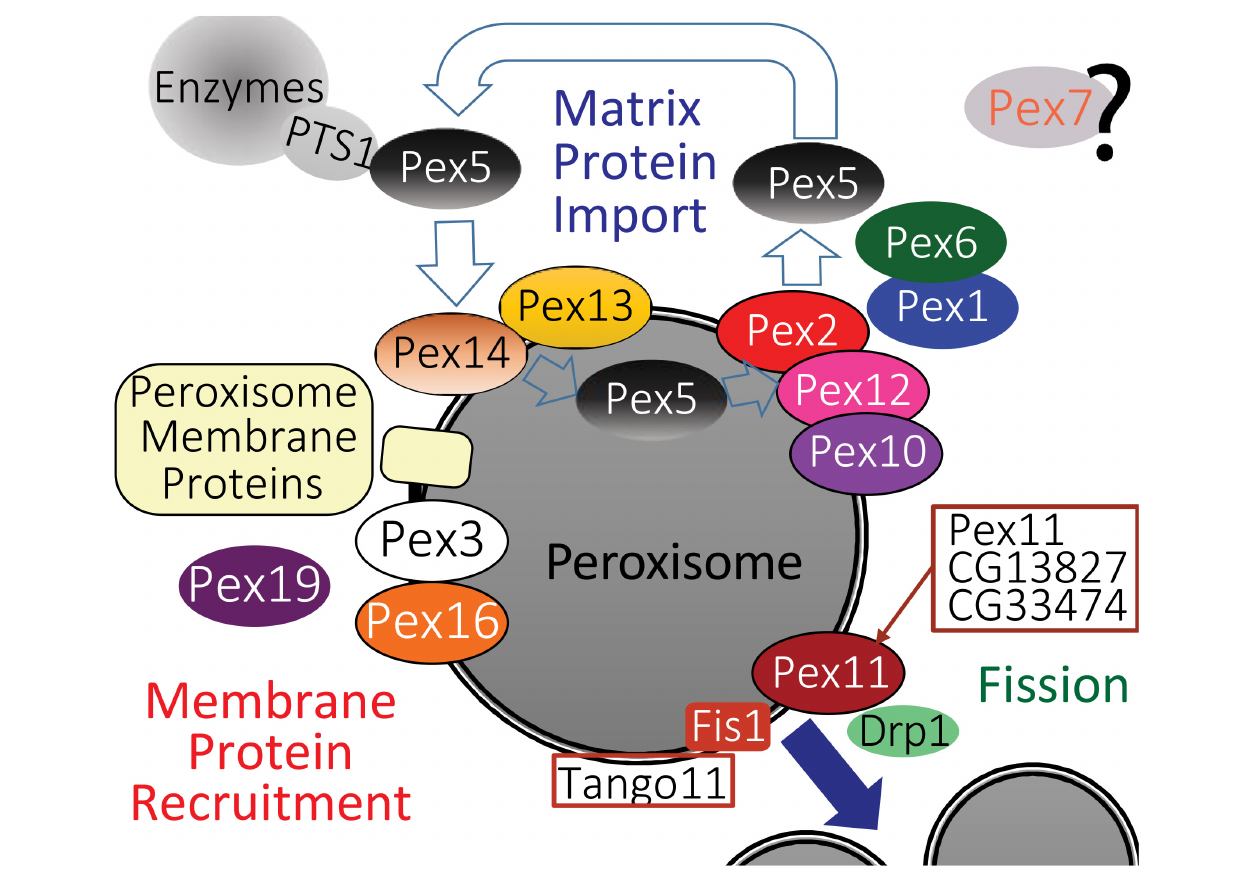
FIGURE 2 | A model for the likely role of the Drosophila homologs of peroxisome biogenesis factors, based on a recent one for mammalian peroxisome proteins by Fujiki et al. (2020). Homologs of Pex proteins ( Table 1 ) required for recruitment and insertion of peroxisome membrane proteins ( Table 2 ), as well as Pex3, Pex16, and Pex19 are all conserved in Drosophila . The peroxisome fission machinery also appears conserved as there are three Drosophila Pex11 proteins (Pex11, CG13827, and CG3374). Fis1 is the homolog of Fission, mitochondrial 1 ( FIS1 ), Tango11 is homologous to Mitochondrial fission factor ( MFF ) and Drp1 is the homolog of Dynamin 1 like ( DNM1L ), all of which are required for peroxisome fission in mammals. Drosophila peroxisomal matrix protein import in flies appears dependent on PTS1, mediated by Pex5 binding to PTS1 ( Table 3 ), although some matrix proteins do not have a PTS1 motif ( Table 4 ). The docking complex proteins Pex13 and Pex14 are conserved in Drosophila , as is the RING-E3-ligase complex of Pex2, Pex10, and Pex12. It is therefore likely that Pex5-bound cargos are imported, then Pex5 is recycled to the cytosol by Pex1 and Pex6 in a manner similar to mammals. A Pex7 homolog exists in Drosophila , but its role in peroxisome function is